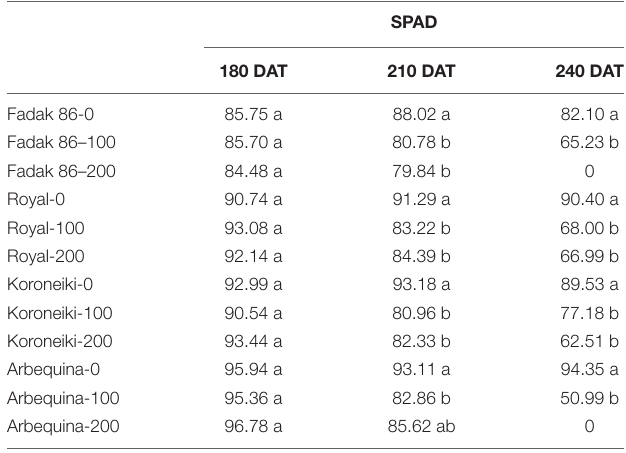
TABLE 3 | Chlorophyll content of leaves of different olive cultivars treated with 0, 100, and 200 mM of NaCl.